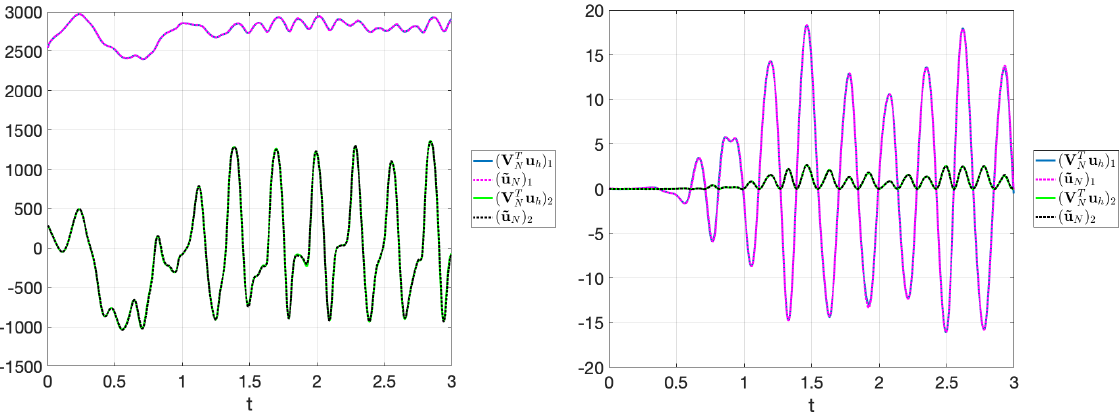
Figure 11. Test case 2: Comparison between the intrinsic coordinates V T proximation ˜u N for the velocity ( left ) and the displacement ( right ) fields for the testing-parameter instance µ [ 2.7 × 10 6 g/(cm · s 2 ),0.375 ] .